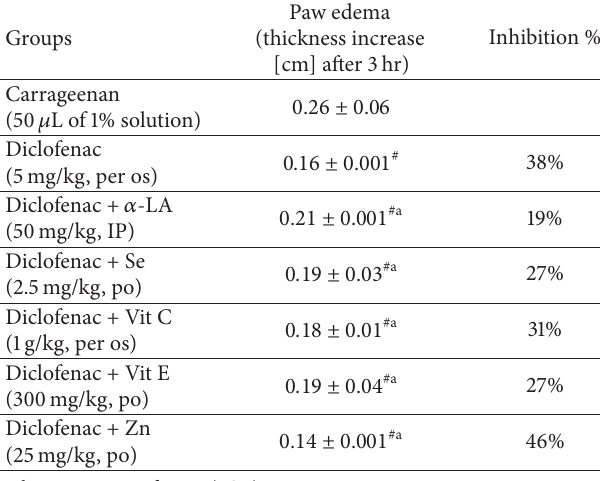
Table 2: Effects of combination treatments of diclofenac and the test antioxidants on paw thickness increase after 3 hr in a rat carrageenan-induced paw edema model.